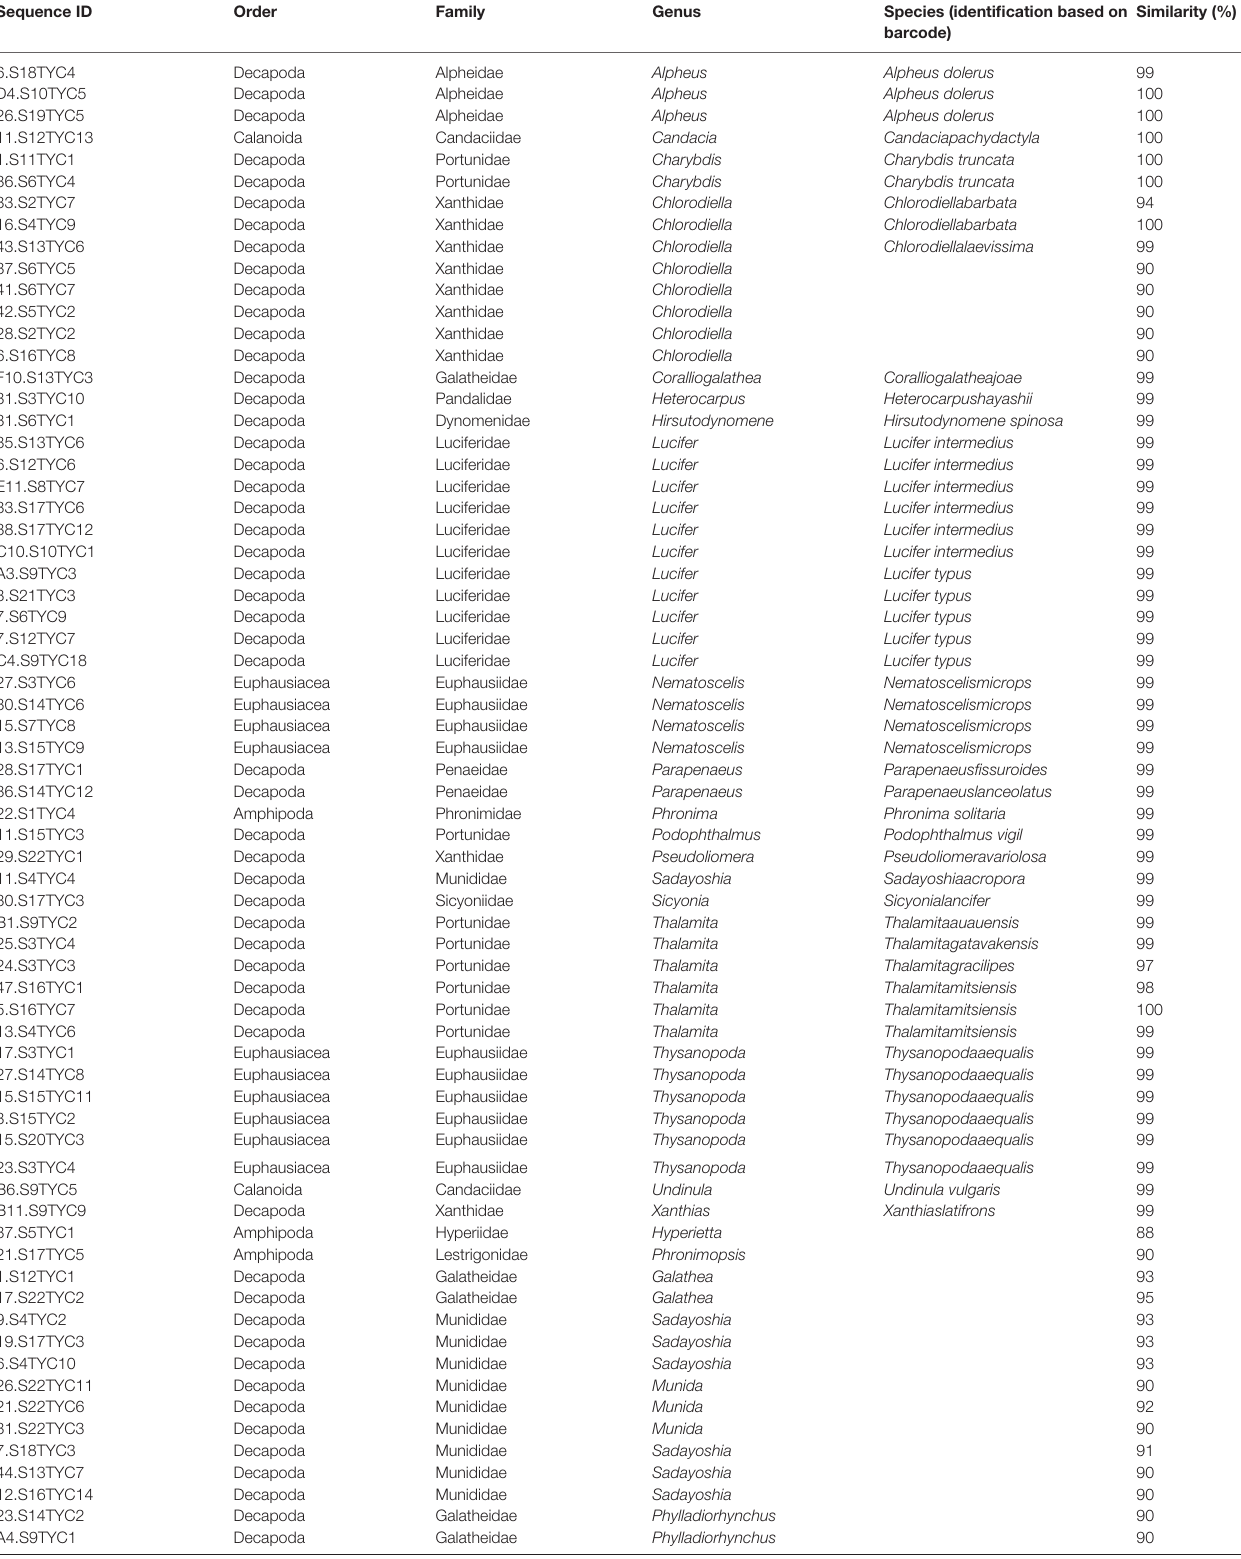
TABLE 1 | Summary of identification based on species barcode using BLAST search from GenBank. Sequence